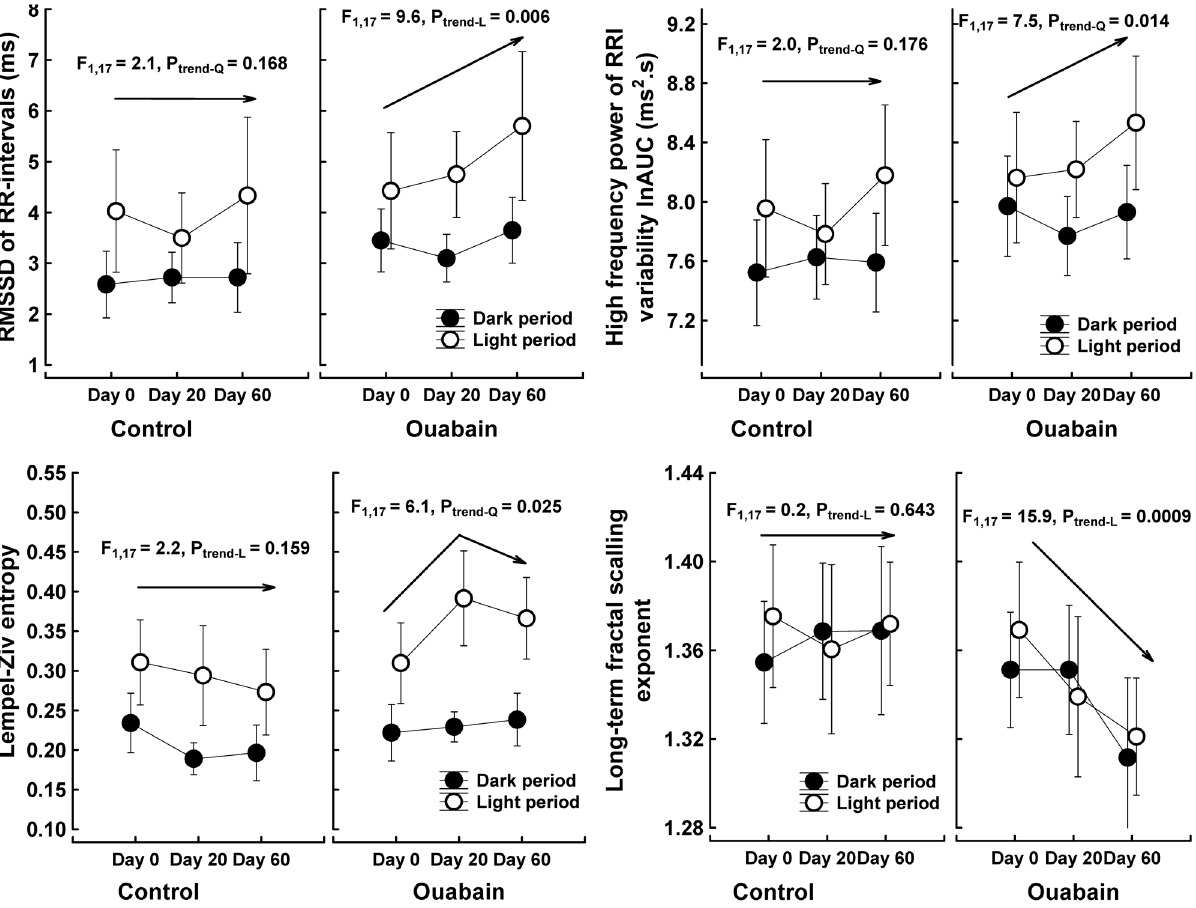
Figure 2. Surrogate measures of cardiac vagal nerve activity derived from the RR-interval variability. The symbols represent the means, and the vertical bars indicate the 95% CIs; n=9 control rats, n=10 ouabain-treated rats. Day 0, rats were not treated with ouabain; Day 20, rats were treated for 20 days with 63 m g ouabain/kg/day; Day 60, rats were treated for 40 days with 63 m g ouabain/kg/day and then 20 days with 324 m g ouabain/kg/day. RMSSD, square root of the mean sum of the squares of differences between adjacent RR-intervals; AUC, area under curve; ln, natural logarithm; F, univariate F-test value, subscripts are degrees of freedom; P trend , probability that a relationship (L-linear, Q-quadratic) between the time and RRI variability is a coincidence. The arrows denote the trend analysis for the light period. The main effects and their interactions were tested with repeated measures MANOVA and the multivariate Wilk’s test; the between groups main effect ‘‘group’’ was tested with the univariate ANOVA (between-within design; 2 levels of main effect ‘‘group’’ x 2 levels of main effect ‘‘illumination’’ x 3 levels of main effect ‘‘time/ouabain treatment’’; the MANOVA results are in Tables S3 and S5. Significant simple effects were identified with the contrast and trend analyses of a priori defined